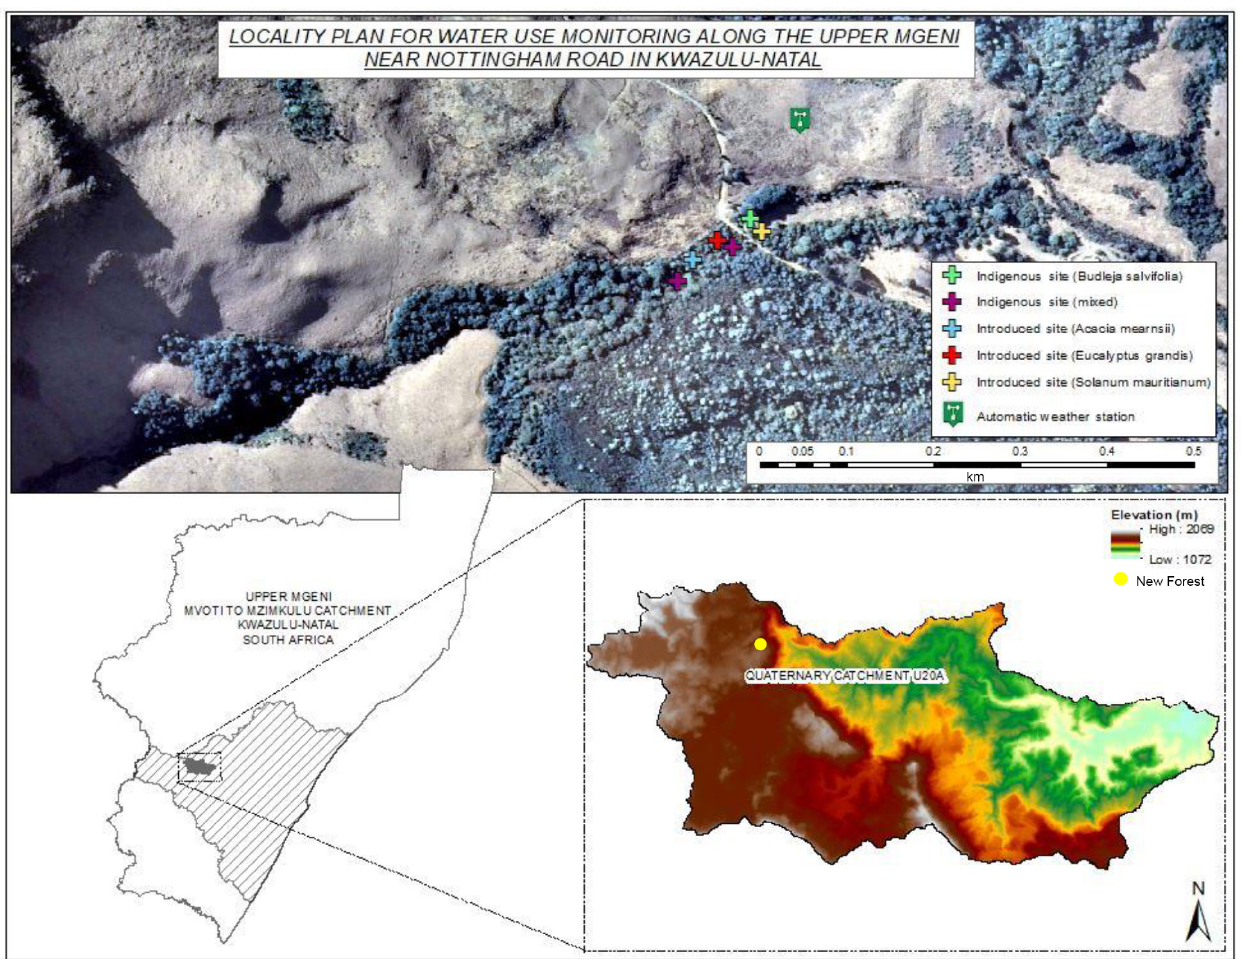
Figure 1. Location of the New Forest farm research area within KwaZulu-Natal, South